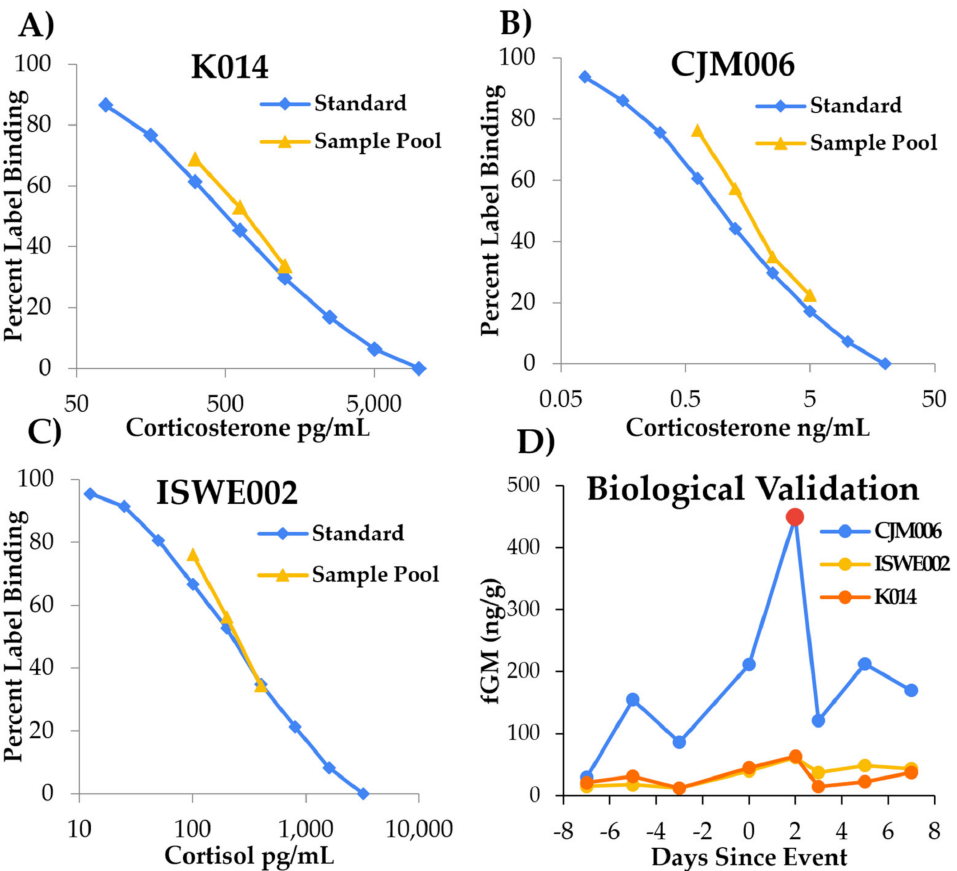
Figure 1. Orangutan fecal glucocorticoid metabolite (fGM) validations. ( A ) Corticosterone EIA #K014 (Arbor Assay), ( B ) Corticosterone EIA CJM006 (C. Munro, University of California, Davis), ( C ) Cortisol EIA ISWE002 (Arbor Assay), ( D ) Biological fGM validation. Data greater than 2 standard deviations above the mean considered significantly elevated ( •